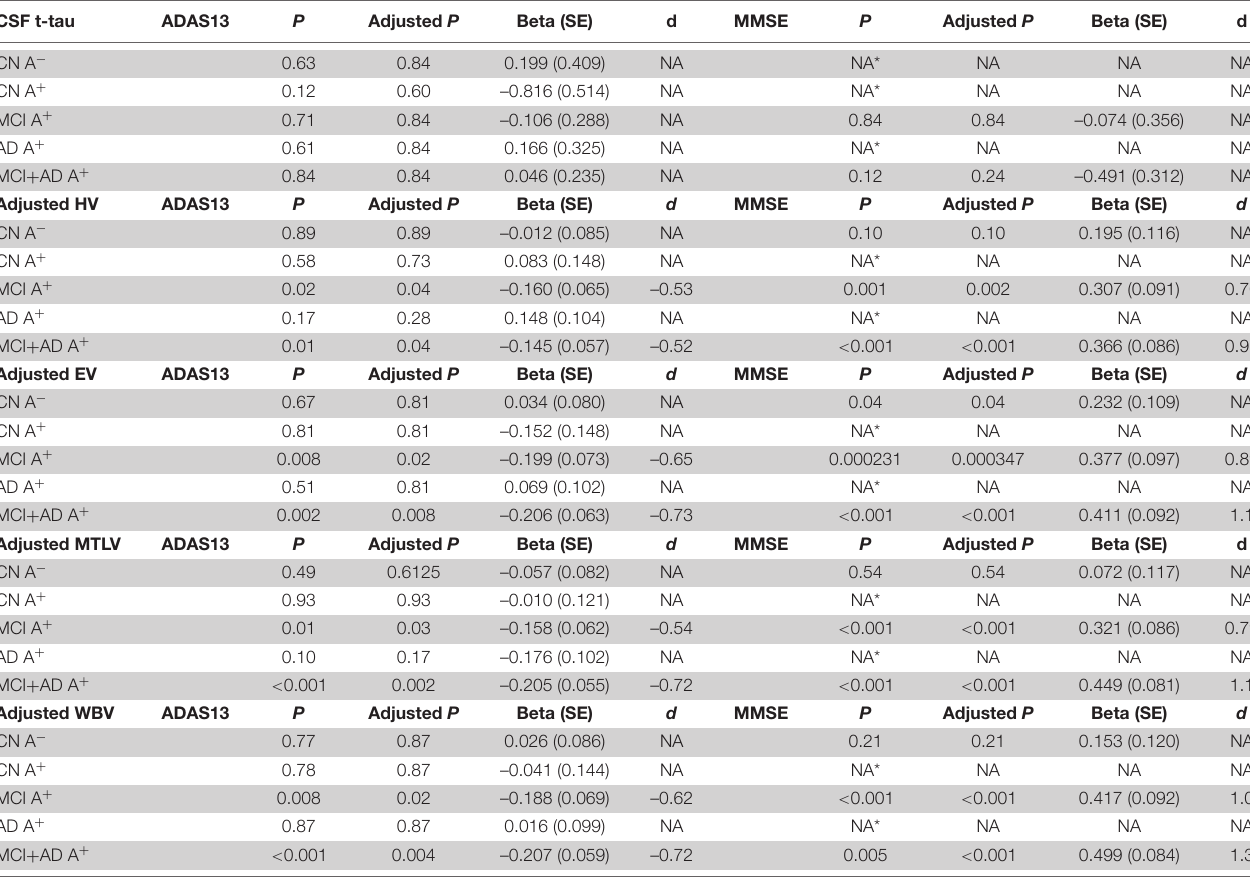
TABLE 6 | Statistical analysis of linear mixed-effect regression for CSF t-tau concentration and specific brain region volumes (segmented in 3.0 T structural MRI) in amyloid positive (A + ) groups alone or in combination. CSF t-tau ADAS13